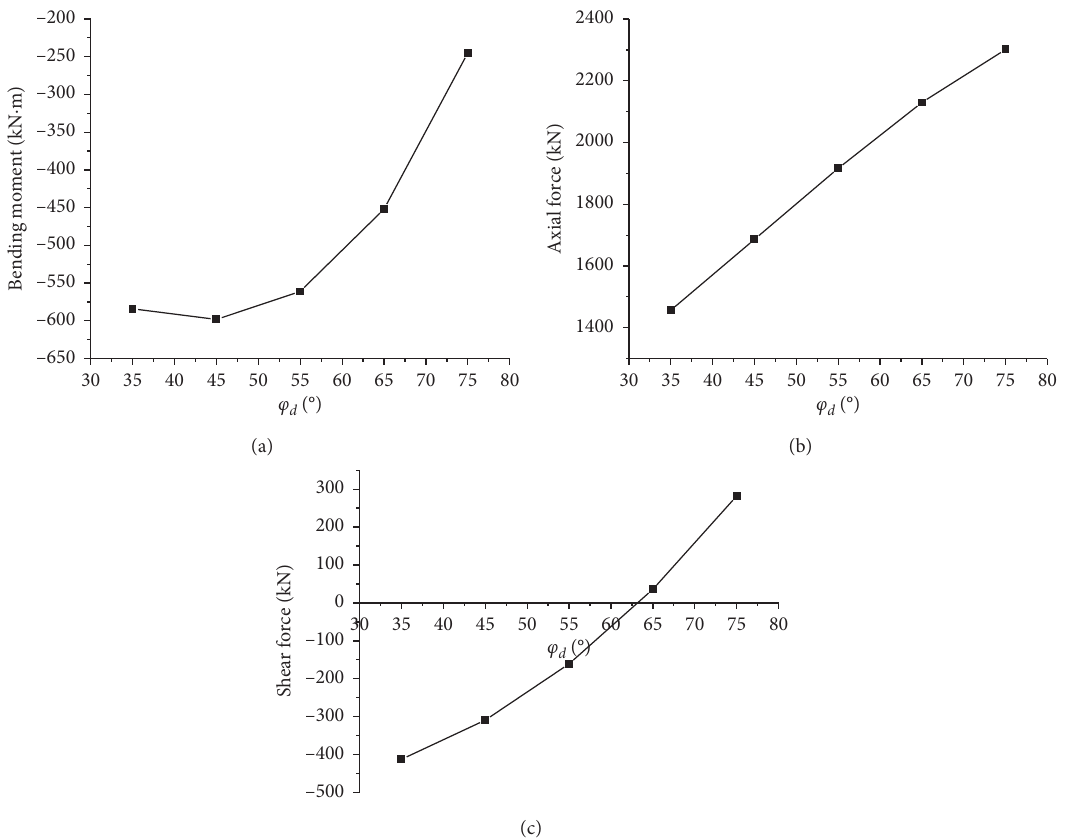
Figure 21: Variations of internal forces at the contact interface between the arch ring and the top of the middle wall with φ moment; (b) axial force; (c) shear